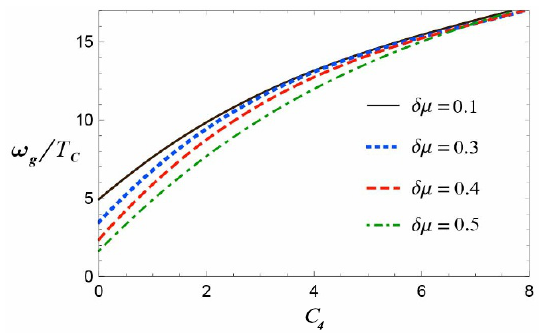
Figure 8. Plot of the ! g =T c as a function of C 4 for (cid:14)(cid:22) = 0 : 1 ; 0 : 3 ; 0 : 4 ; 0 : 5 (solid curve, dotted curve, dashed curve, dot-dashed curve). Here, we have (cid:12)xed T = 0 : 3 Tc and considered the numerical threshold Re [ (cid:27) ] = 0 : 005 to numerically de(cid:12)ne ! g .